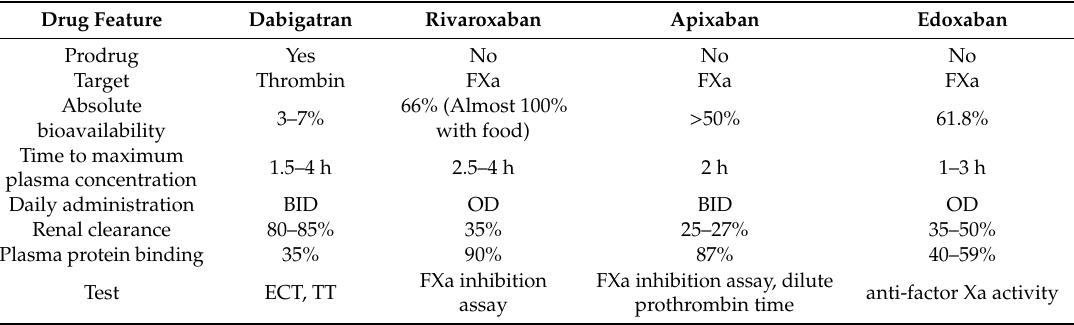
Table 2. Summary of the pharmacokinetic profile of DOACs after oral